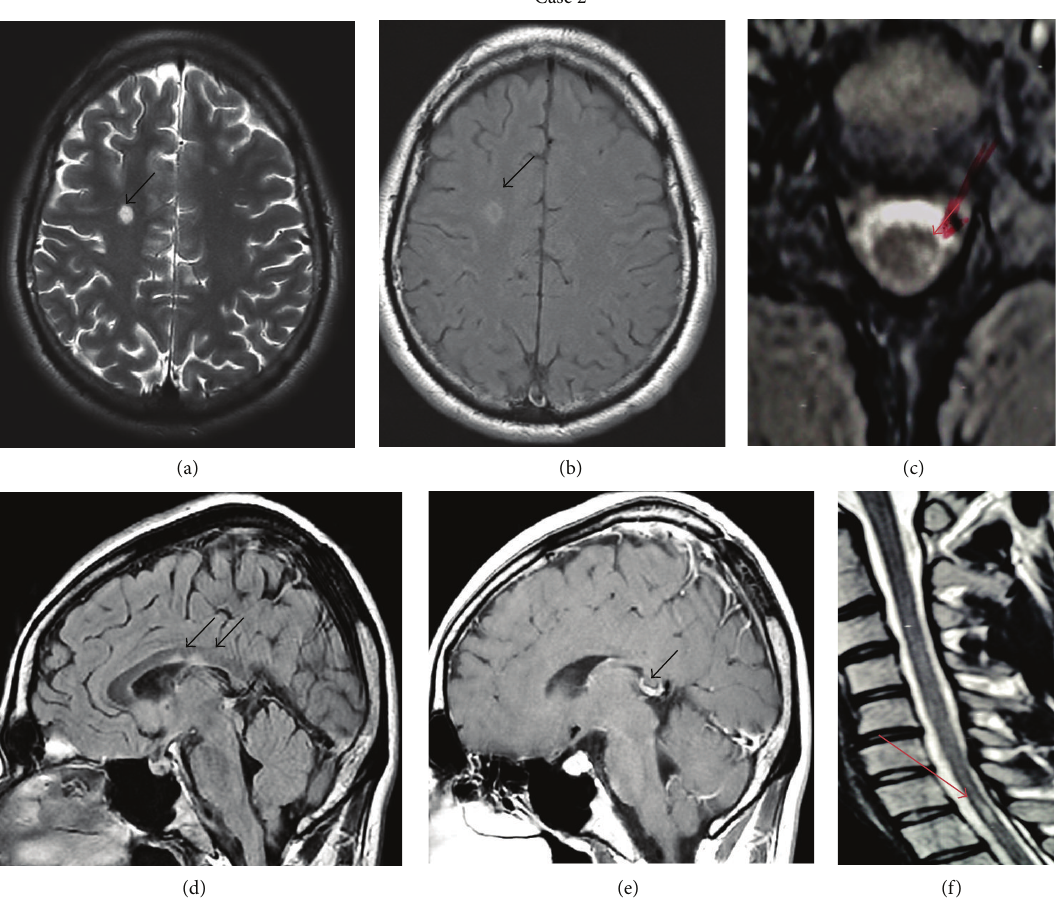
Figure 2: (a) Axial T2- and (b) T1-weighted brain MRI of the second patient showing subcortical hyperintense lesions, one with contrast enhancement (black arrows). (d) and (e) Sagittal T1 weighted with gadolinium brain MRI images showing enhanced corpus callosum lesions (black arrows). (c) Sagittal and (f) axial T2-weighted cervical spine MRI showing one hyperintense lesion (red arrows) on level